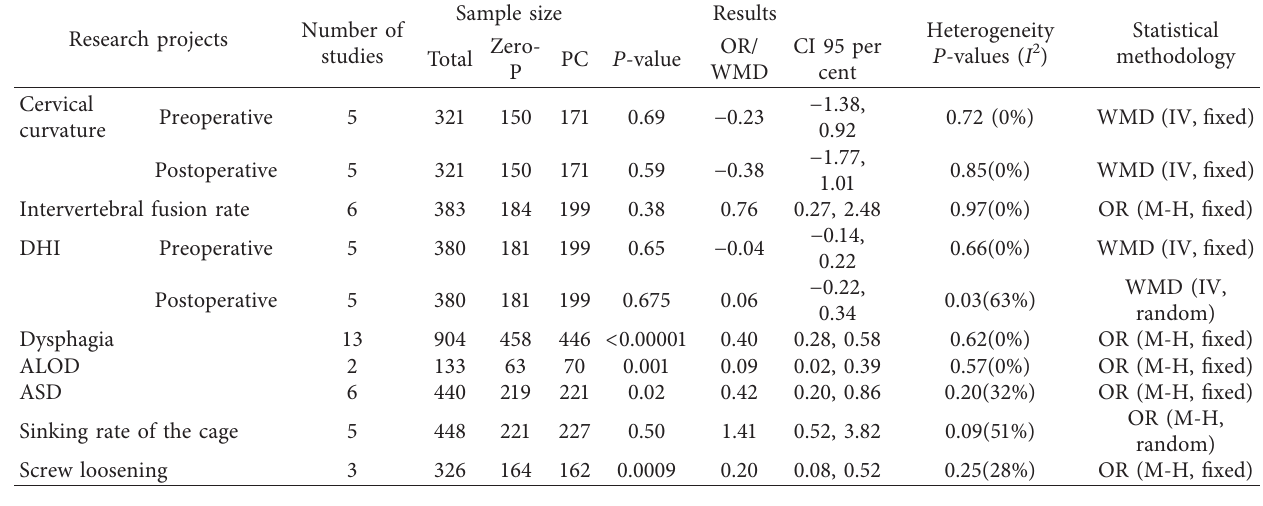
Table 3: Meta-analysis results of included studies.